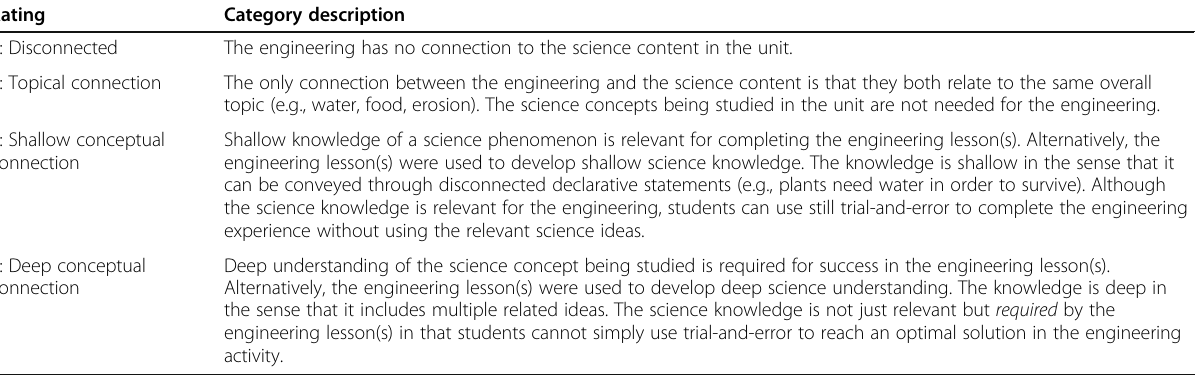
Table 2 Coding frame for ratings of connections to science content Rating Category